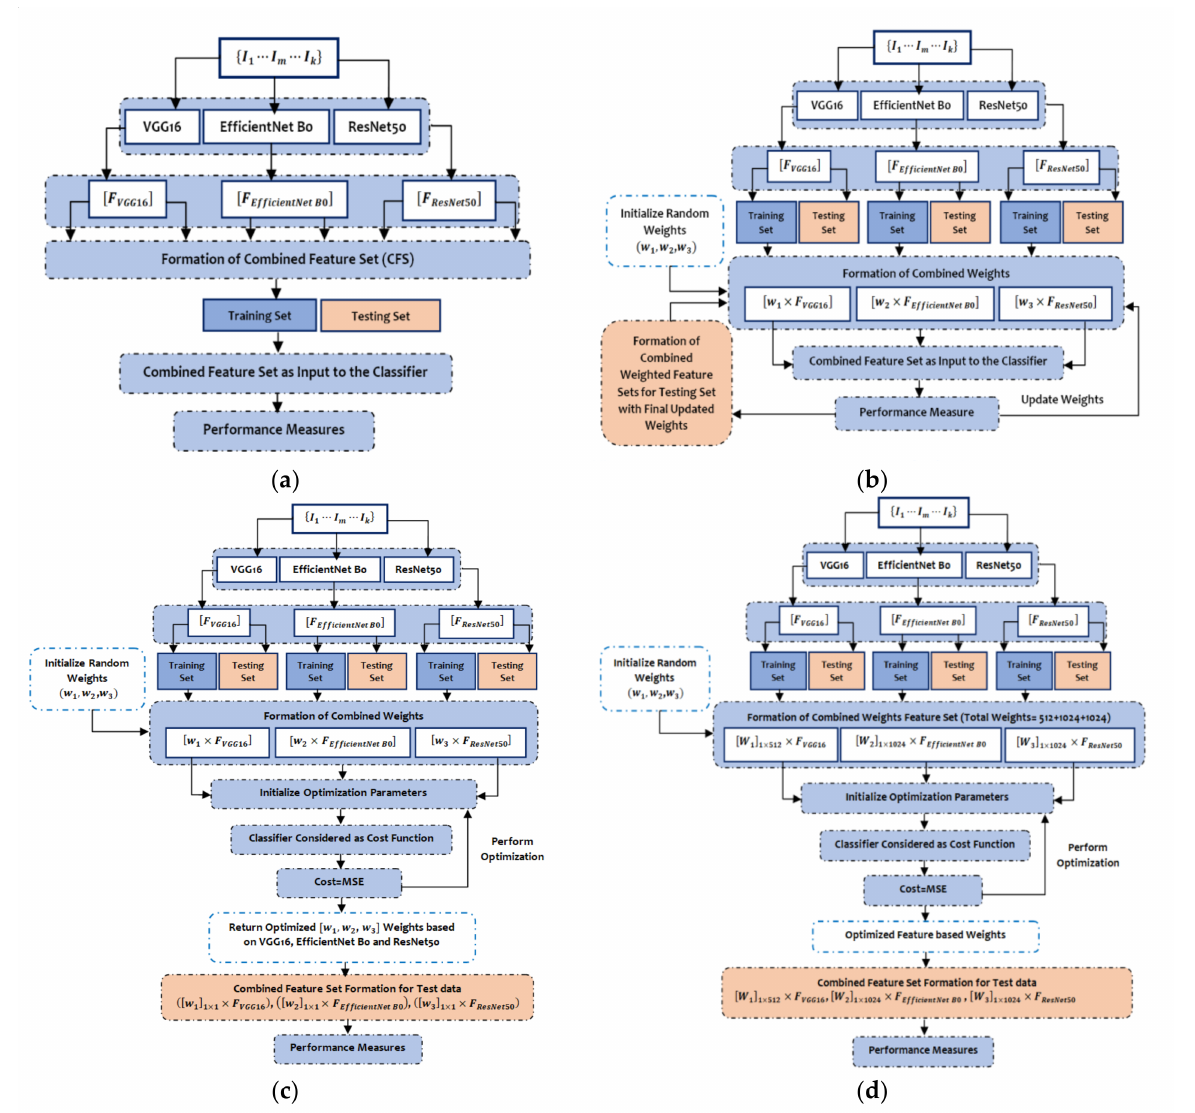
Figure 4. The steps of ( a ) Combined Feature Set (CFS) generation process; ( b ) Adaptive Weighted Feature Set (AWFS) generation process; ( c ) Model-based Optimized Weighted Feature Set (MOWFS) generation process; and ( d ) Feature-based Optimized Weighted Feature Set (FOWFS) generation